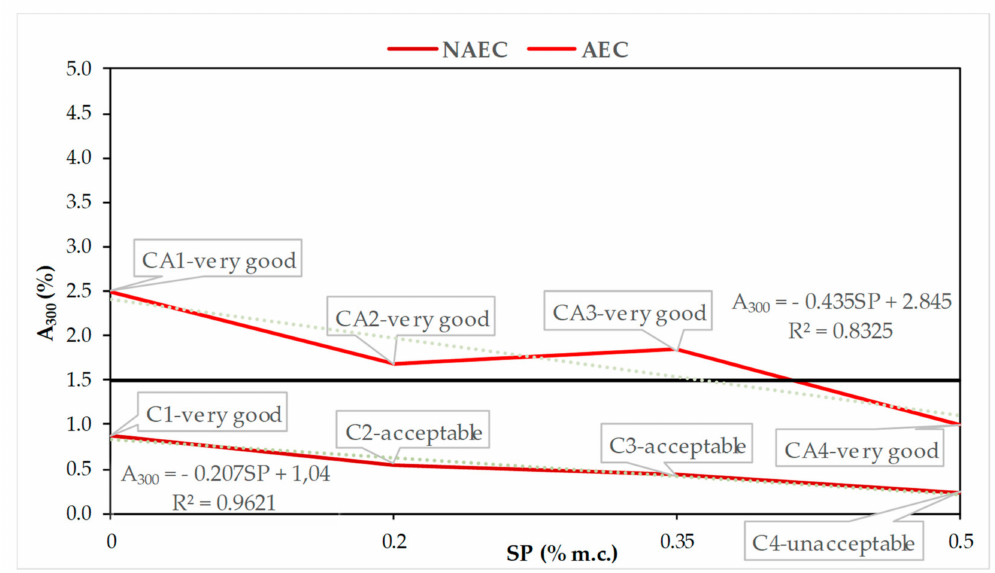
Figure 8. Dependences between A 300 and SP contents in NAEC and